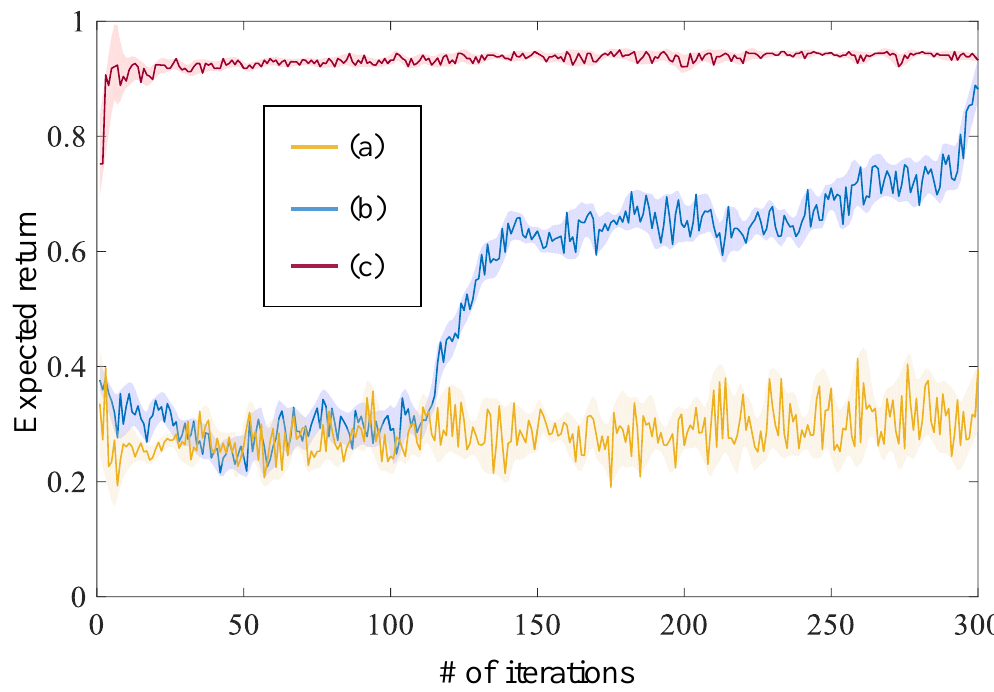
Figure 9. Expected returns of policy parameters with respect to number of iterations in the peg-in-hole task: (a) (yellow line) using only a HMM (without a DMP learned from human demonstrations); (b) (blue line) using only a DMP (without a HMM learned from human demonstrations); and (c) (red line) using both a HMM and a DMP. The average and variances of multiple RL trials from four different directions for the “hole search” and the “peg insertion” motor skills are